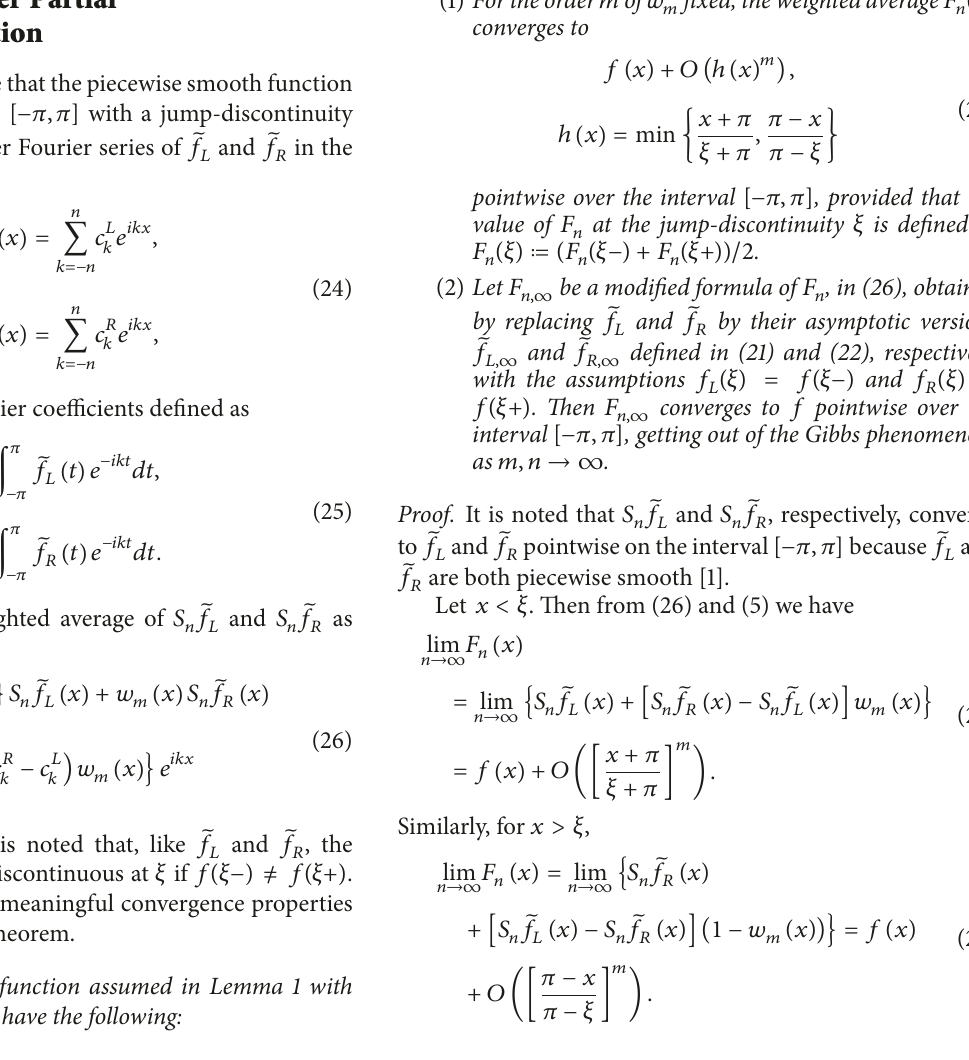
Figure 2: Graphs of the extended functions